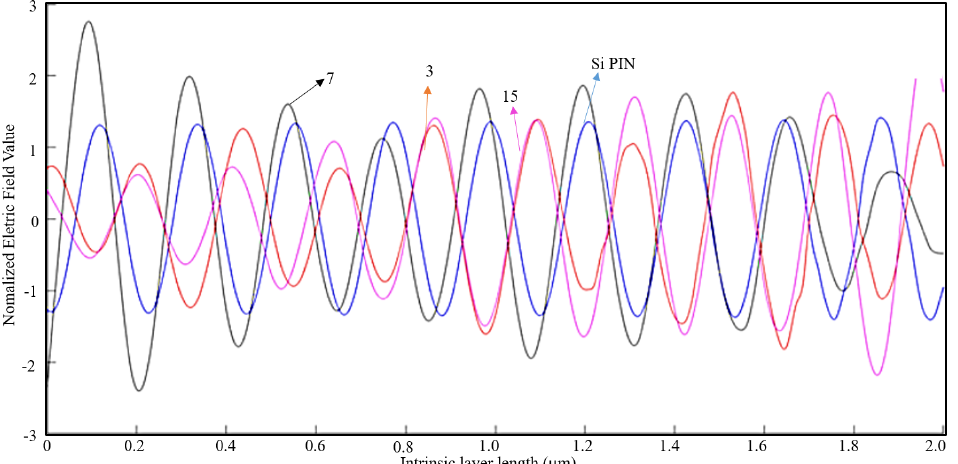
Figure 16. 1D Plot of the normalized electric field, z-component, along the intrinsic zone for a light wavelength of 800 nm (metal thickness: λ /100; air slit width: λ /2).